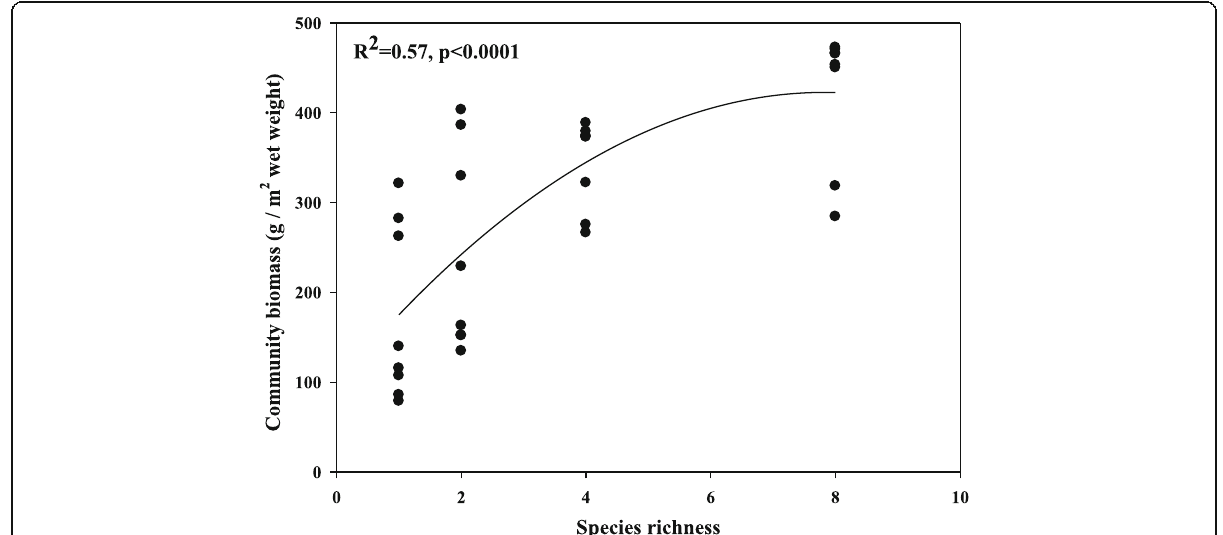
Fig. 1 The relationship between community productivity and plant biodiversity in an aquatic macrophytes experiment, which was conducted from August to October 2018 at Hongshan Bay in Lake Erhai, Dali City, Yunnan Province,